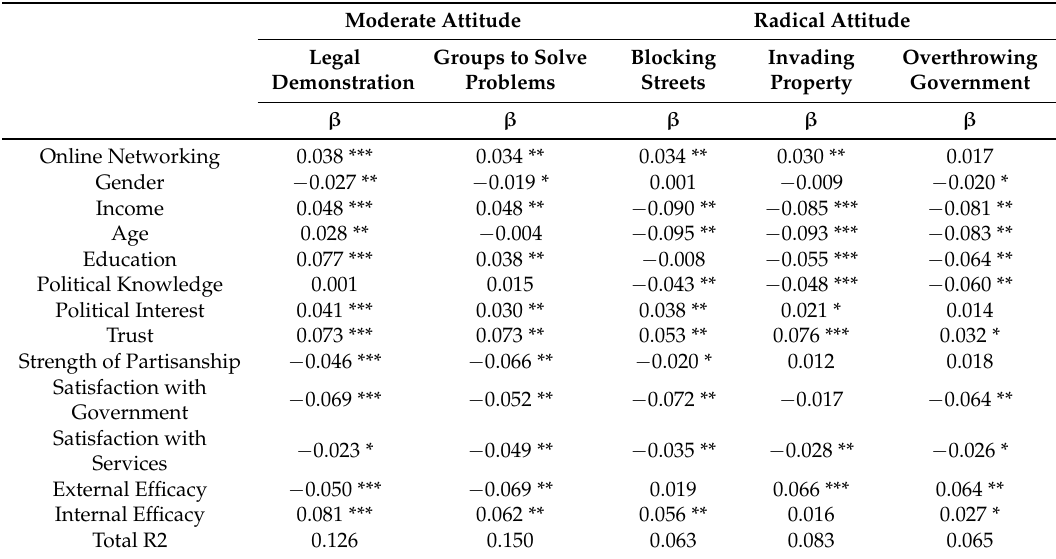
Table 4. Linear Regression Models for Protest